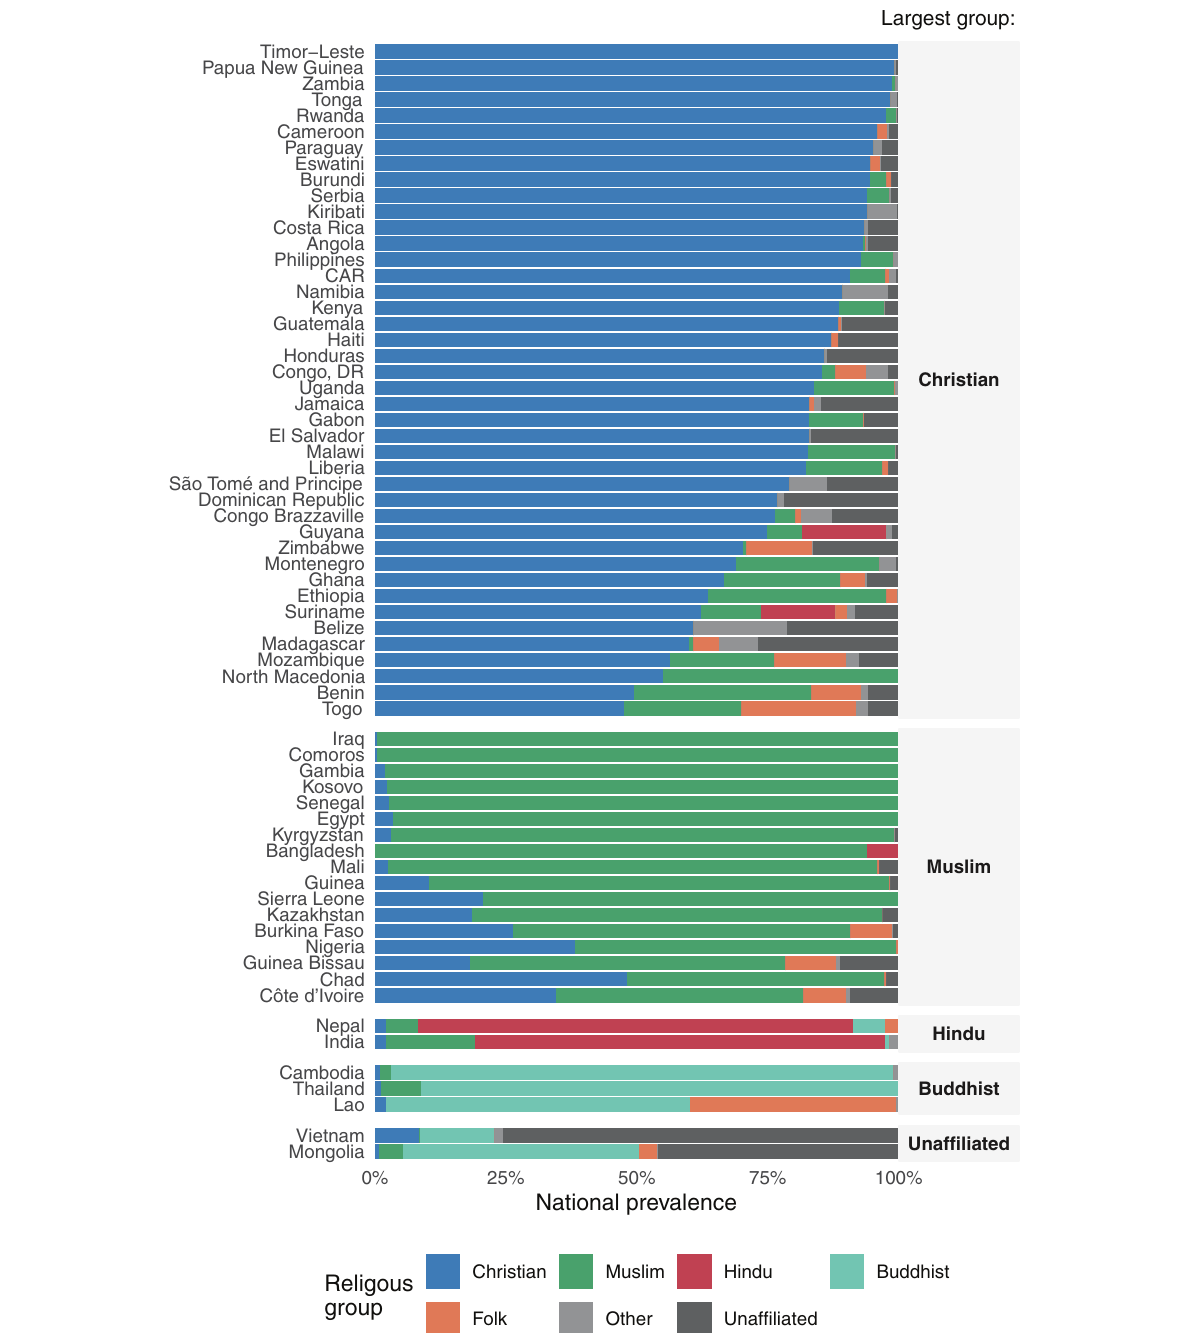
FIGURE1 Distributions of the samples of children according to religious group, by country.